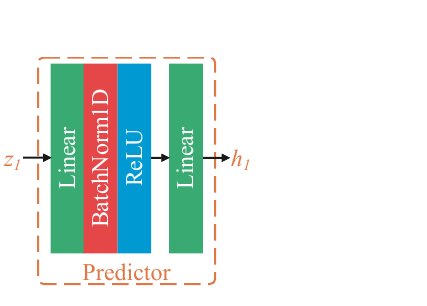
Figure 4. The architecture of the two-layer MLP